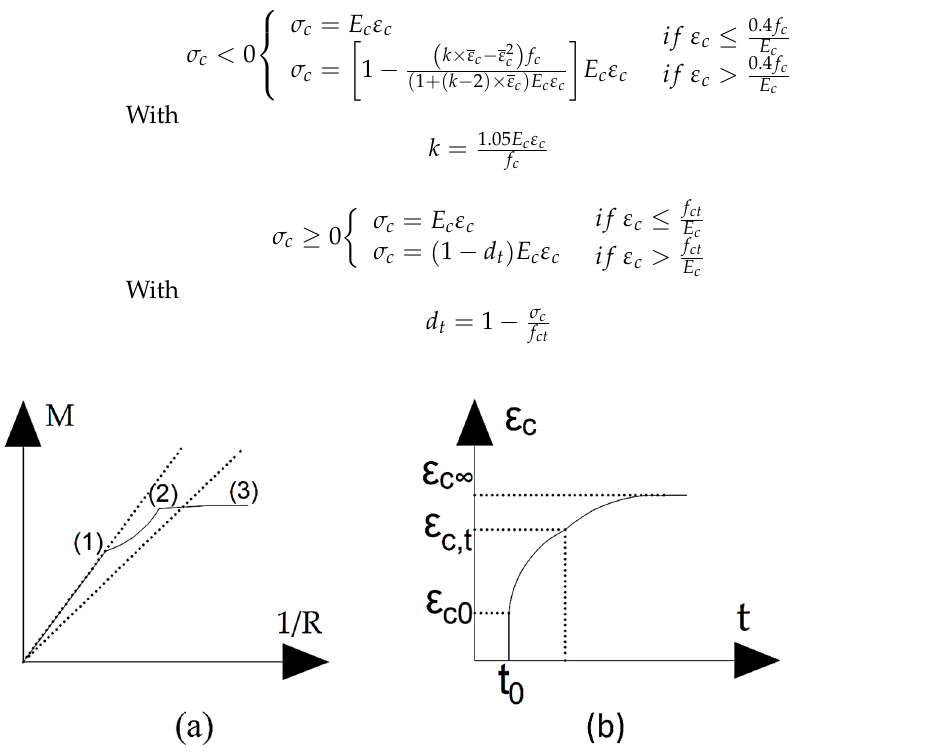
Figure 5. ( a ) Momentum-curvature curve of reinforced concrete, adapted from [21], ( b ) Illustrative